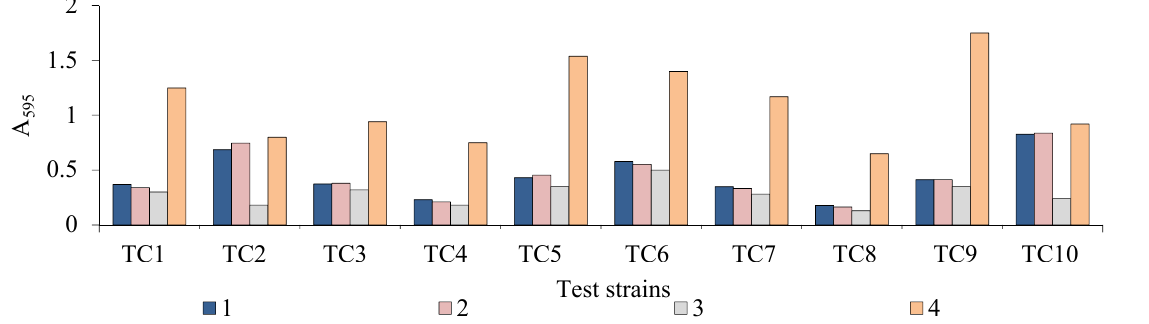
Fig. 1. Results of the determination of antimicrobial properties of cedar oil in a liquid nutrient medium: (1) oil (cold pressing); (2) oil (heat pressing); (3) Control 1 (the antibiotic ciprofloxacin); (4) Control 2 (a nutrient medium without oil). The data are expressed as a mean ± standard deviation ( n = 5). TC1 is Pseudomonas aeruginosa ATCC 9027, TC2 is Candida albicans EMTC 34, TC3 is Alcaligenes faecalis EMTC 1882, TC4 is Leuconostoc mesenteroides EMTC 1865, TC5 is Escherichia coli ATCC 25922, TC6 is Enterococcus casseliflavus EMTC 1866, TC7 is Salmonella enterica ATCC 14028, TC8 is Staphylococcus aureus ATCC 25923, TC9 is Bacillus mycoides EMTC 9, TC10 is Proteus vulgaris ATCC